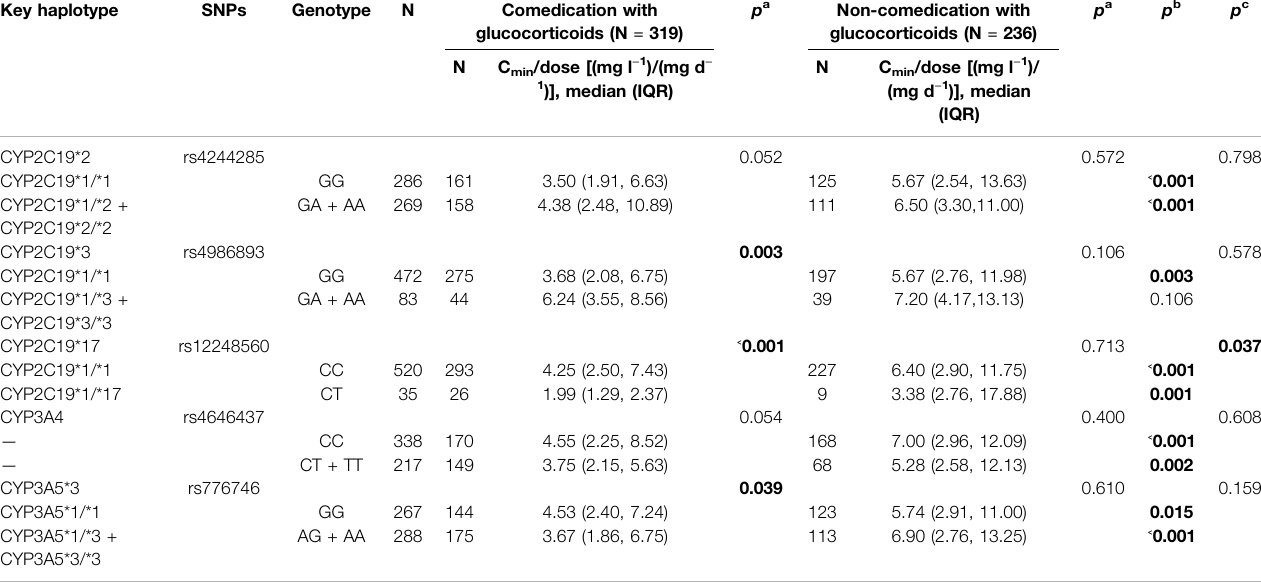
TABLE 4 | Effects of candidate SNPs on C min /dose of VRC in comedication or non-comedication with glucocorticoids. Key haplotype